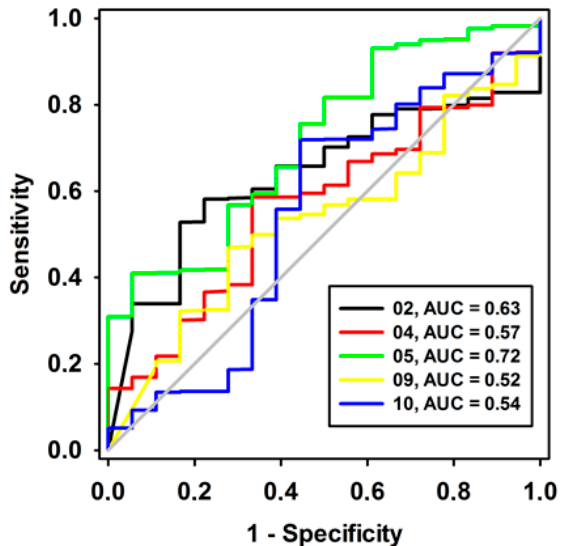
Figure 3. ROC curves of pharmacophore models here investigated, containing low strain energy. The diagonal line represents a model that would not be better than a randomic one (AUC <